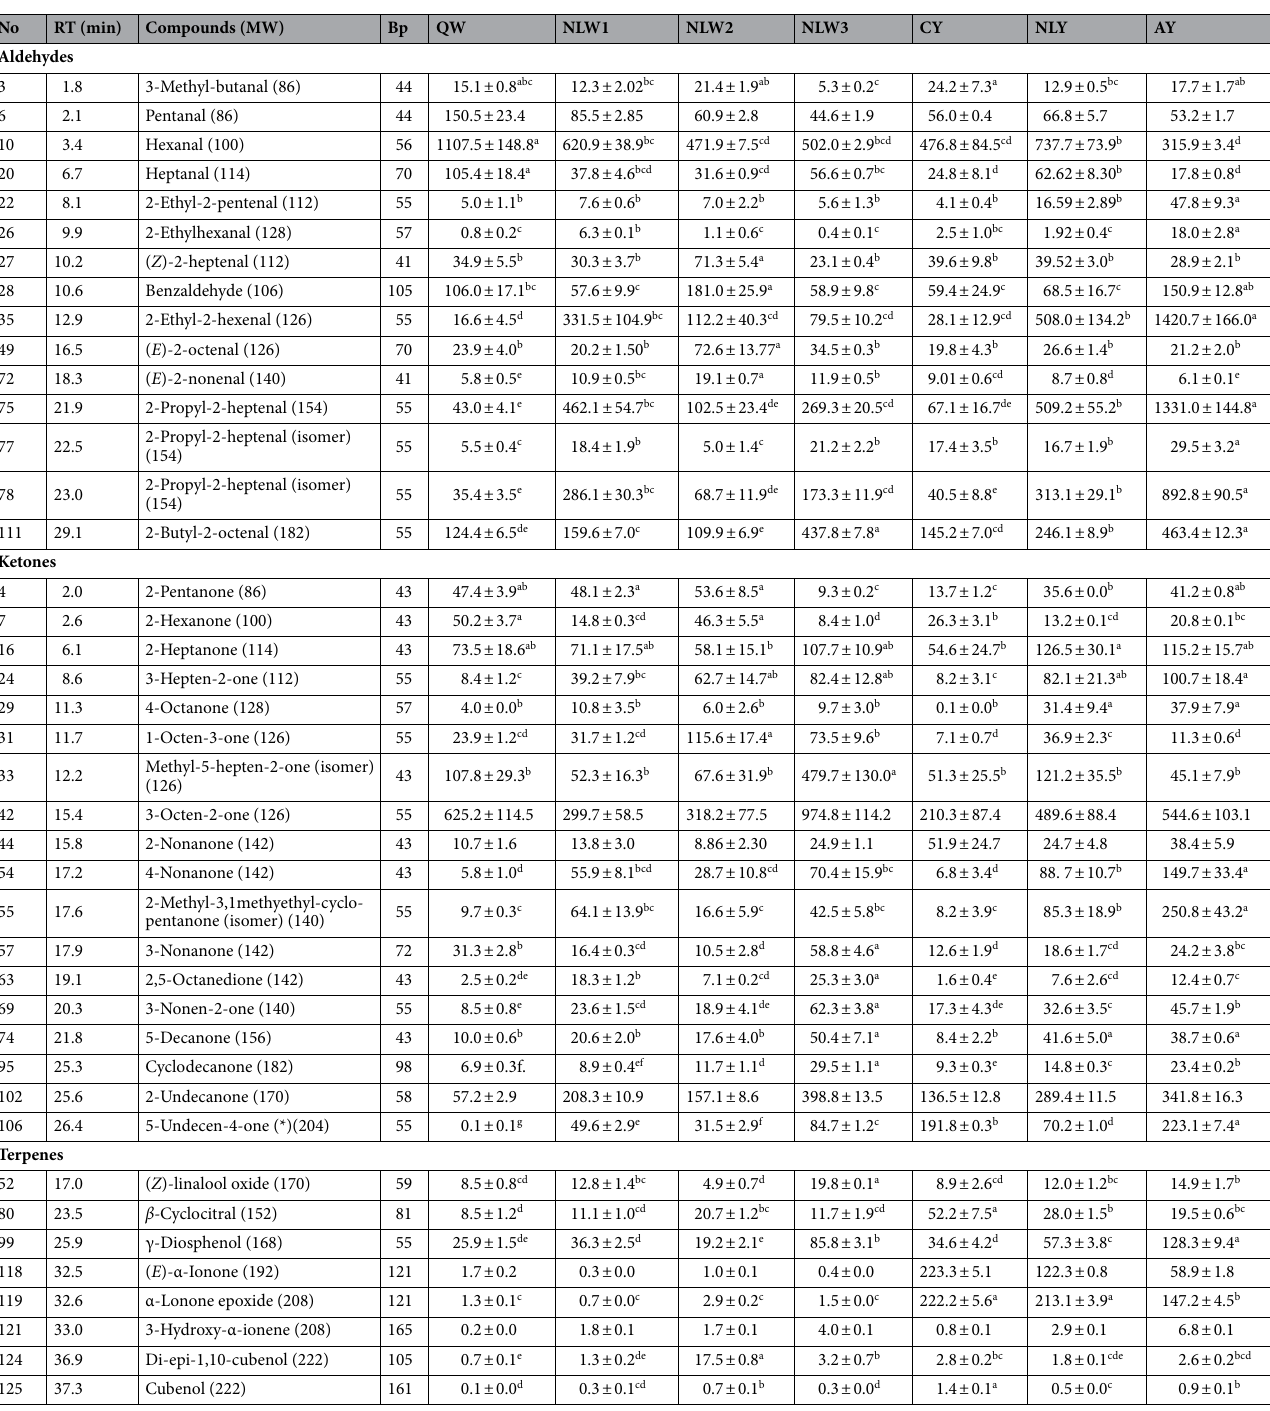
Table 4. Abundances of the volatile metabolites, expressed as area counts of the mass spectra base peak (bp) of each compound × 10 –6 , from the headspace of white (QW, NLW1-3) and golden (CY, NLY, AY) variants of Newfoundland chanterelles extracted by SPME and separated, identified and semi-quantified by GC/MS. Values (means ± standard errors; n = 2) represent the abundances, expressed as area counts of their mass spectra base peak (Bp) divided by 10 6 . Rows with different letters show significant differences between treatments at α = 0.05. *Tentatively identified; Bp base peak, MW molecular weight, RT retention time. Sample codes AY: Cantharellus betularum (golden); CY: C. camphoratus (golden); NLW1–3: C. enelensis (Newfoundland, white 1–3); NLY: C. enelensis (Newfoundland, golden); QW: C. enelensis (Québec,